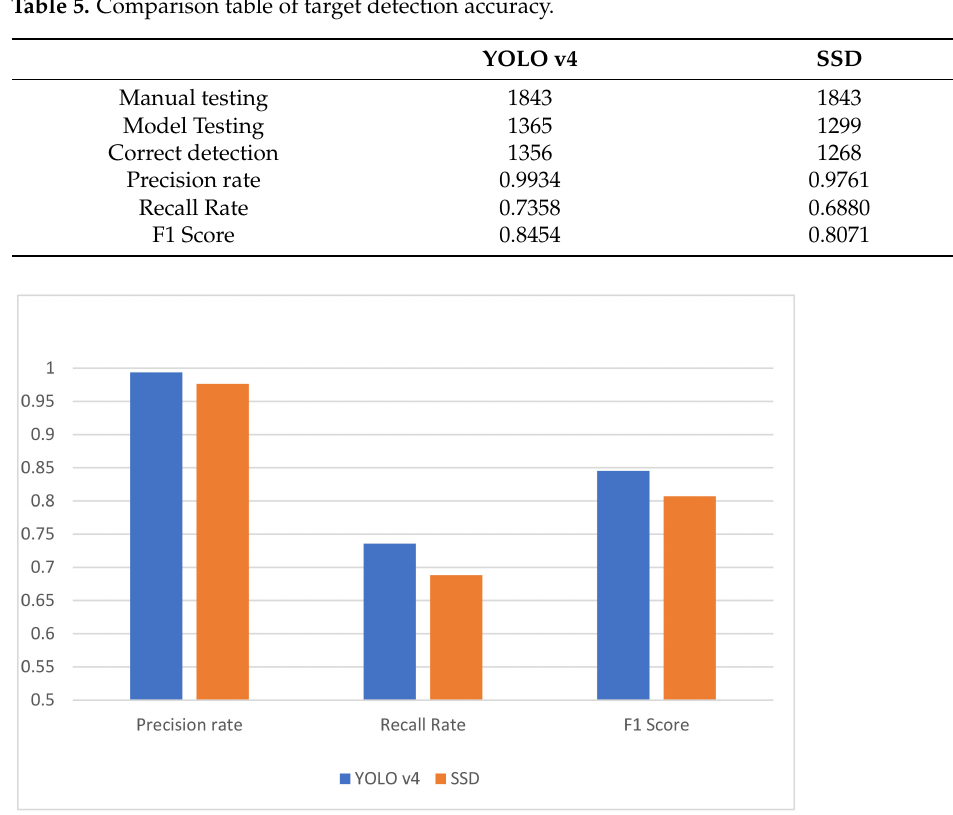
Figure 10. YOLO v4 and SSD detection accuracy